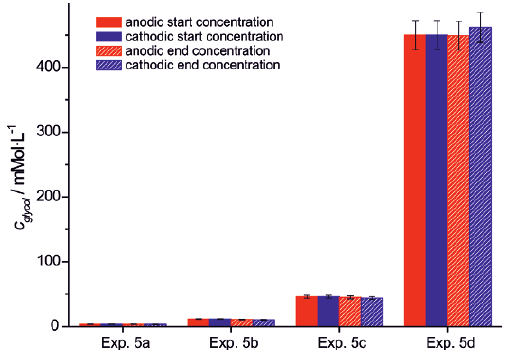
Figure 19. Concentration comparison after the equilibrium experiments (5a-5e). The bridges were run for 600 s except Exp. 5c which was run for 250